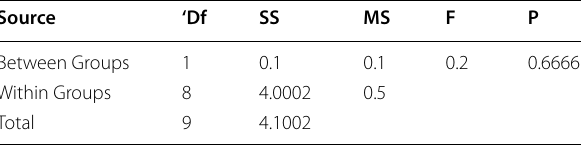
p -value: 0.66659.